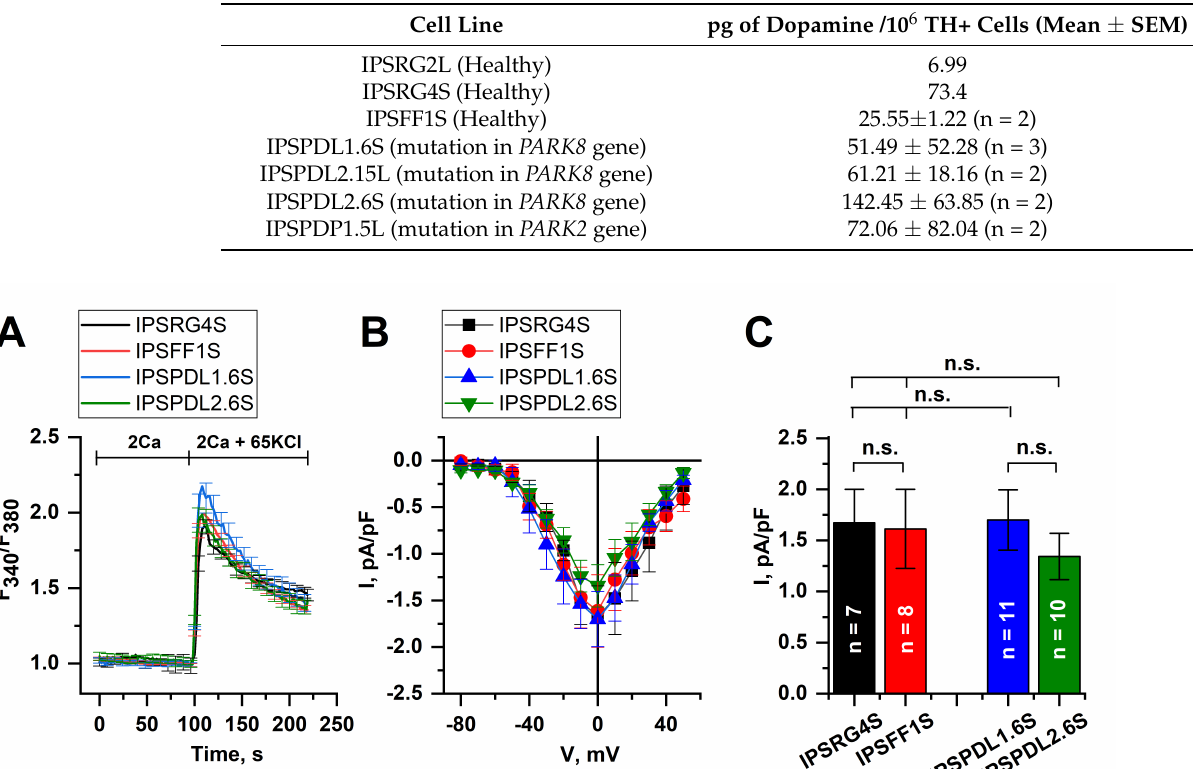
Table 2. Level of spontaneous dopamine release by TH+ neurons differentiated from iPSC lines derived from PD patients and healthy donor.